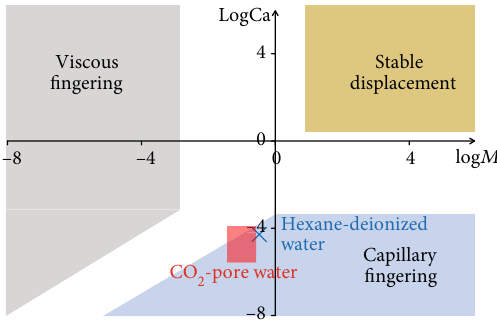
Figure 2: Log M - logCa phase diagram showing three immiscible displacement patterns of fl uids in porous media and the area of the scCO -water and hexane-water displacement experiments 2 (adapted from Lenormand et al.